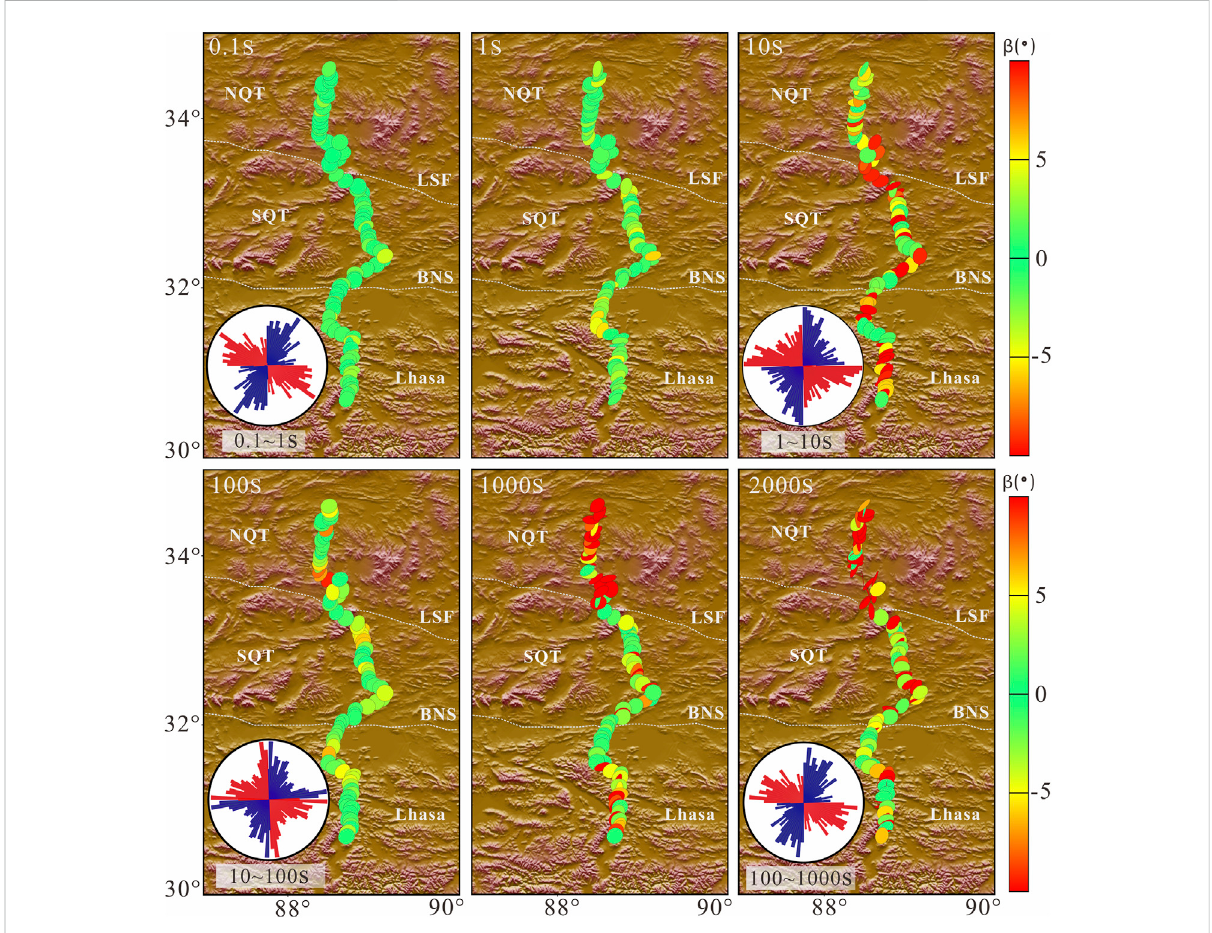
FIGURE 3 Phase tensor skew angle ( β / ° ) for different periods along the pro fi le and rose diagrams showing strike analysis results for each corresponding frequency